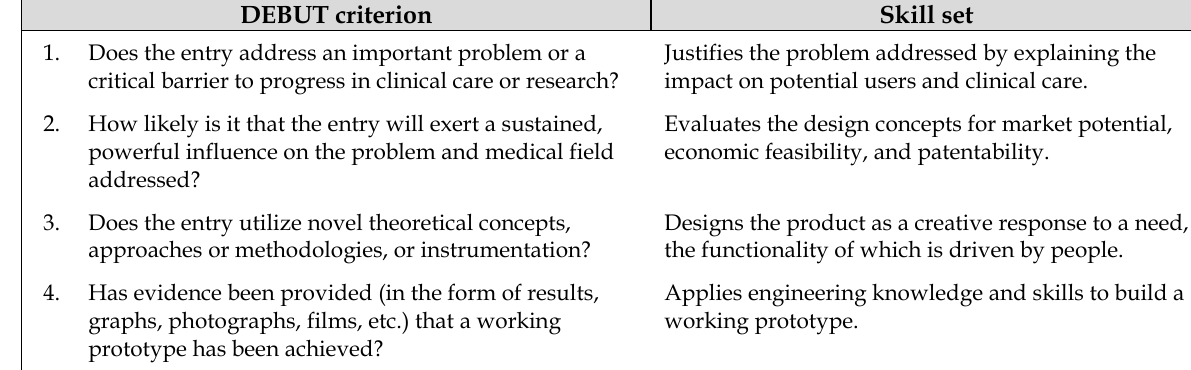
Table 2 Design by Biomedical Undergraduate Teams (DEBUT) criteria and associated skill sets used to measure student